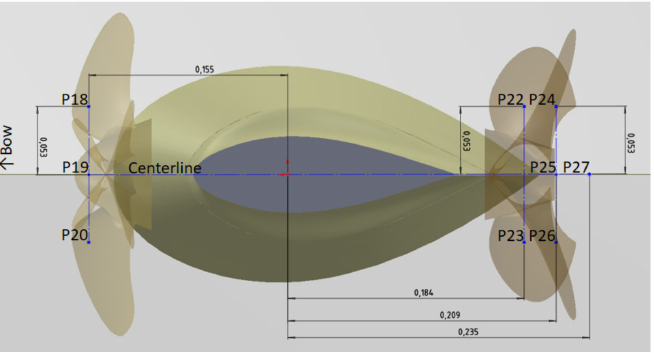
Figure 19. SCHOTTEL reference case 2. Locations of acoustic observers on the hull with respect to the origin located at the vertical shaftline with propellers and the headbox of the unit at model scale; observers are symmetrical to the centerline.